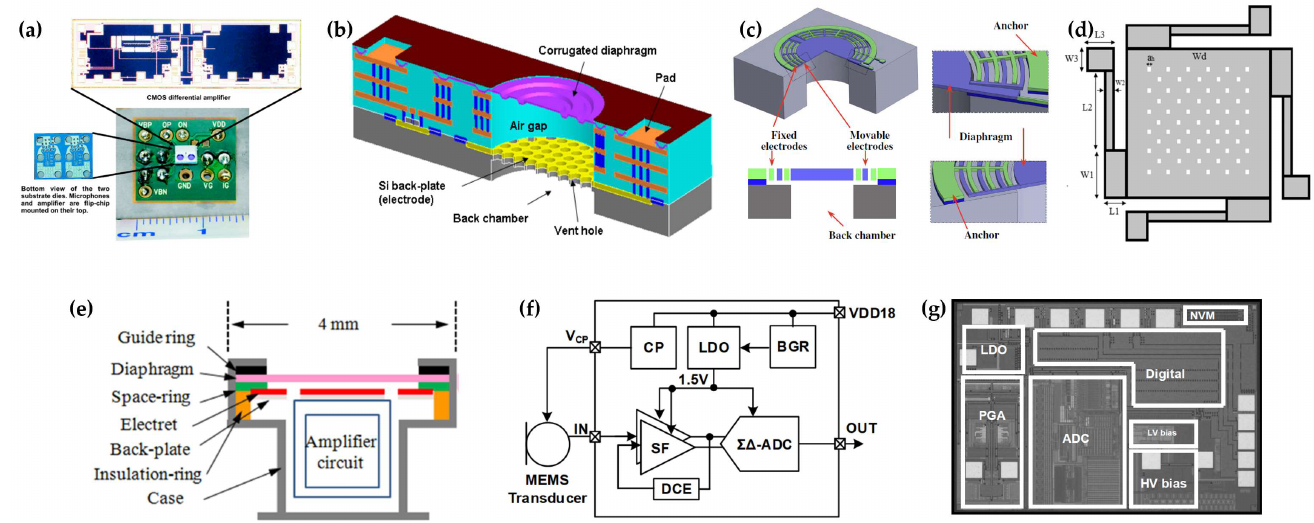
Figure 1. Capacitive MEMS microphones. ( a ) Two MEMS microphones in a differential configuration from Citakovic et al. [11]. ( b ) CMOS MEMS microphone from Huang et al. [12]. ( c ) No-back-plate SOI MEMS microphone from Lo et al. [13]. ( d ) Microphone with Z-shape arms from Ganji et al. [14]. ( e ) Electret capacitive microphone from Woo et al. [15]. ( f ) Microphone based on a triple-sampling delta-sigma ADC from et Lee al. [16]. ( g ) Microphone using differential circuits and internal LDOs from Ceballos et al. [17].